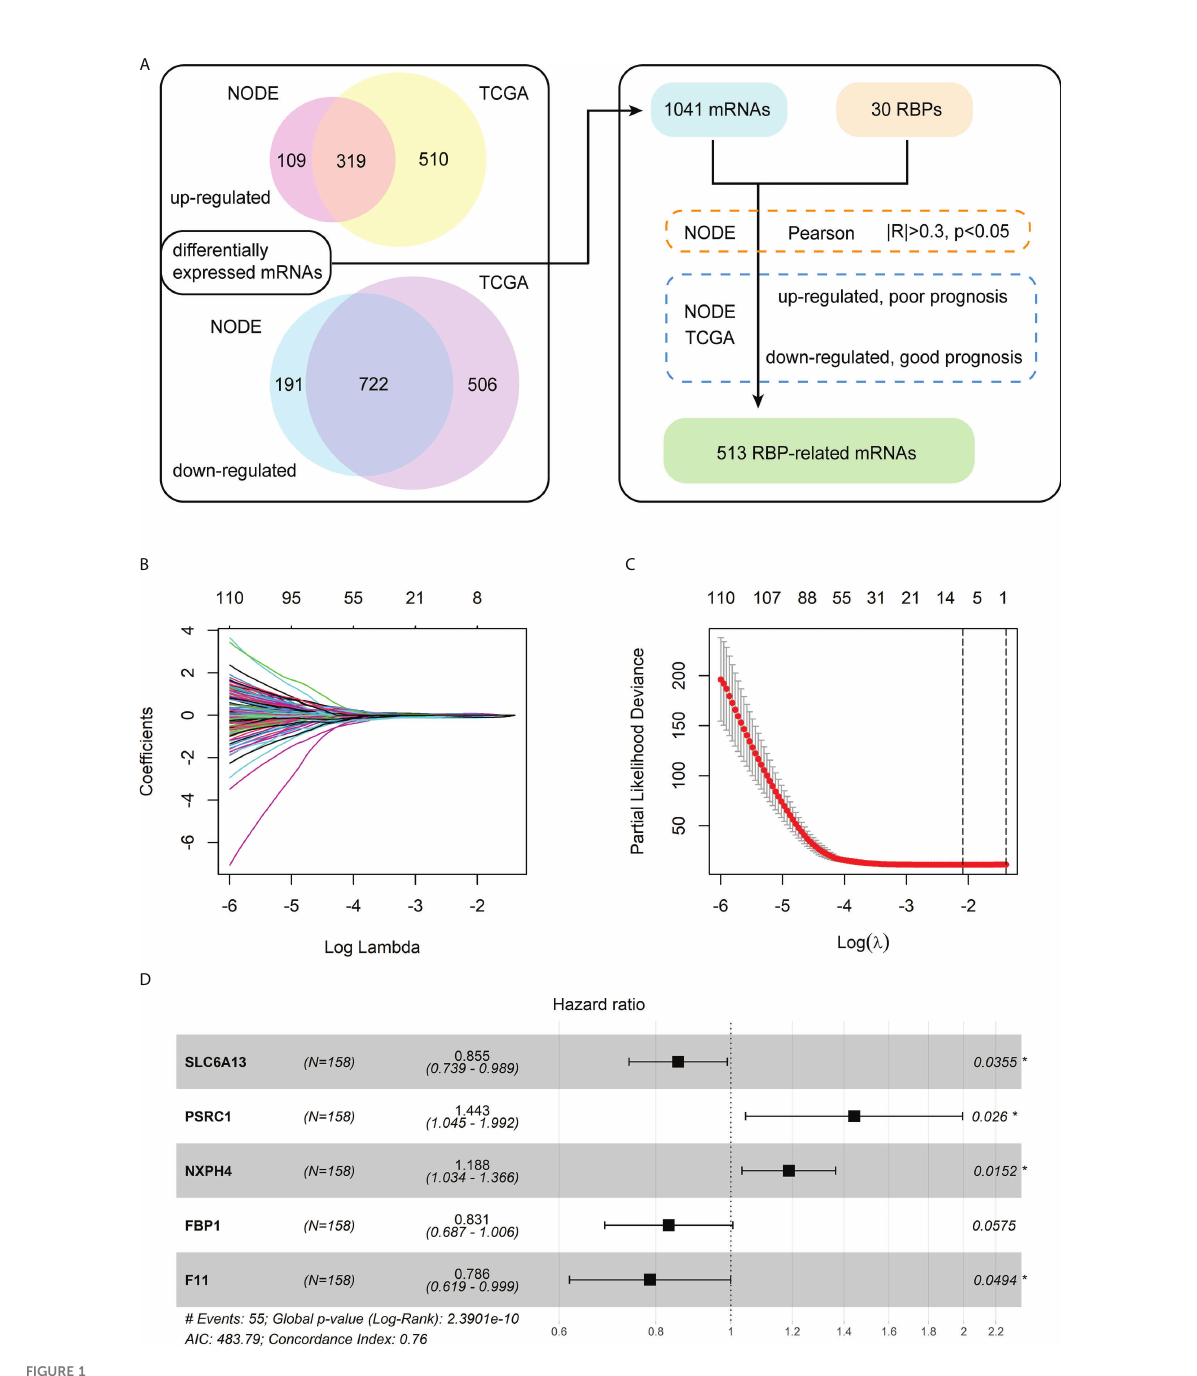
FIGURE 1 Identi fi cation of the differentially expressed mRNAs associated with RBPs and construction of a prognostic model. (A) The fl owchart for identi fi cation of RBP-related mRNAs. (B) The LASSO coef fi cient pro fi les of the RBP-related mRNAs related to OS. (C) The cross-validation plot of LASSO regression Cox analysis shows the optimal parameter selection with minimum criteria (the lambda value corresponding to the black dashed line on the left). (D) Forest plot of the fi ve RBP-related mRNAs obtained via the multivariate Cox regression